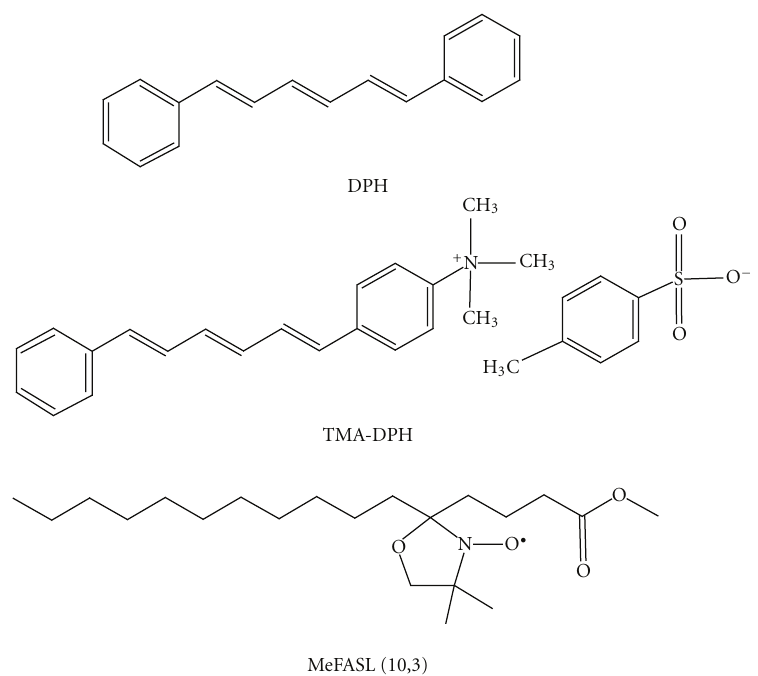
Figure 3: Structural formulas of 1,6-diphenyl-1,3,5-hexatriene (DPH), trimethylammonium-6-phenyl-1,3,5-hexatriene (TMA-DPH), and methylester of 5-doxyl palmitic acid [MeFASL